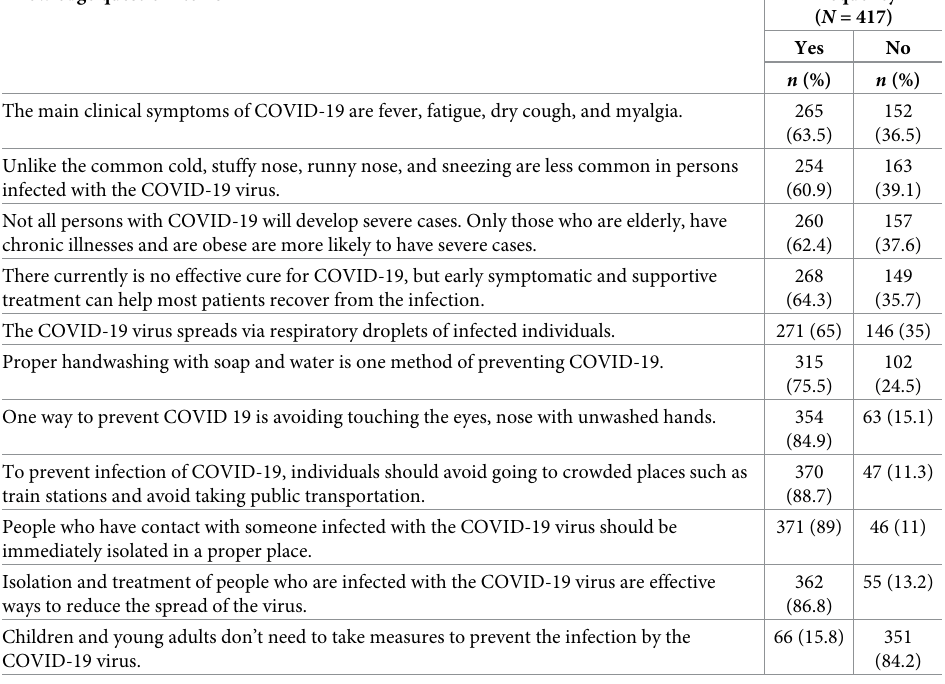
Table 2. Knowledge of COVID-19 among taxi drivers, in Dessie City and Kombolcha Town, Ethiopia, July to August 2020. Knowledge question items Frequency